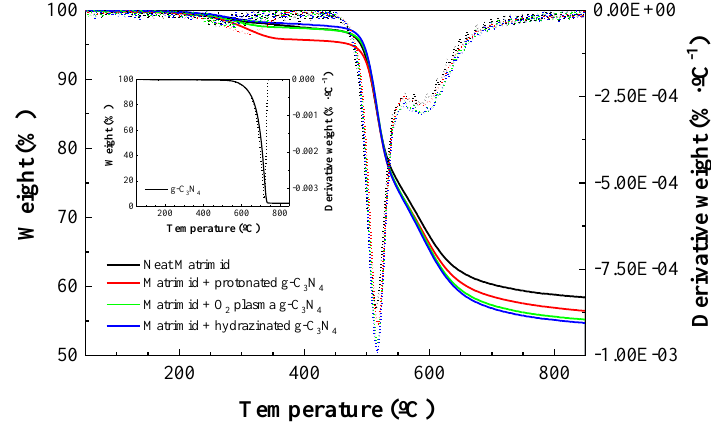
Figure 5. TG (solid line, y -axis on the left side of the graph) and DTG (dashed line, y -axis on the right side of the graph) curves for neat Matrimid and Matrimid-based membranes doped with 0.5 wt % of protonated g-C 3 N 4 , hydroxylaminated g-C 3 N 4 , and hydrazinated g-C 3 N 4 . The inset shows the TG/DTG curves for the untreated g-C 3 N 4 filler. Table 1. TG curves features for neat Matrimid, the g-C 3 N 4 filler and the three MMMs under study Pristine Matrimid